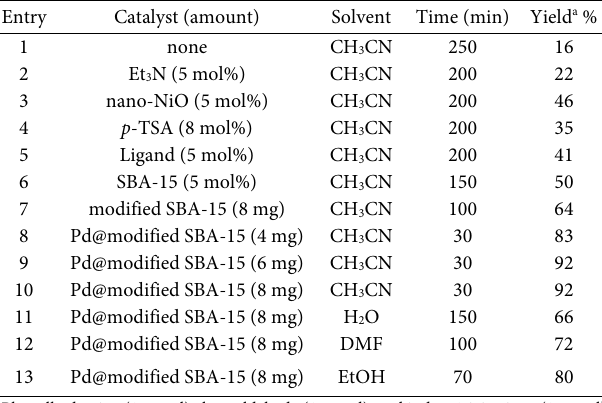
Table 2. Optimization of reaction conditions using different catalysts a